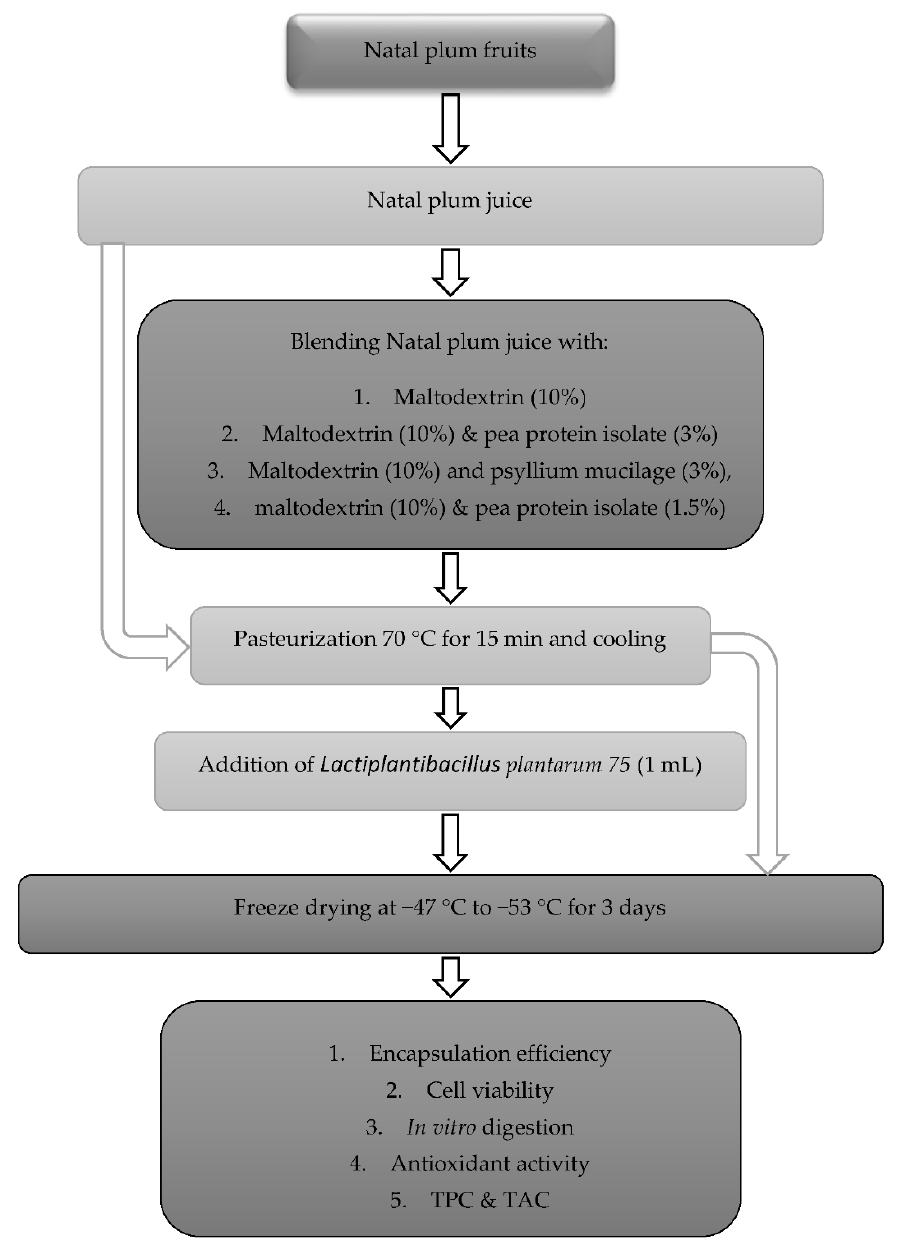
Figure 1. Schematic representation of the experimental design. Table 1. Sample formulations.